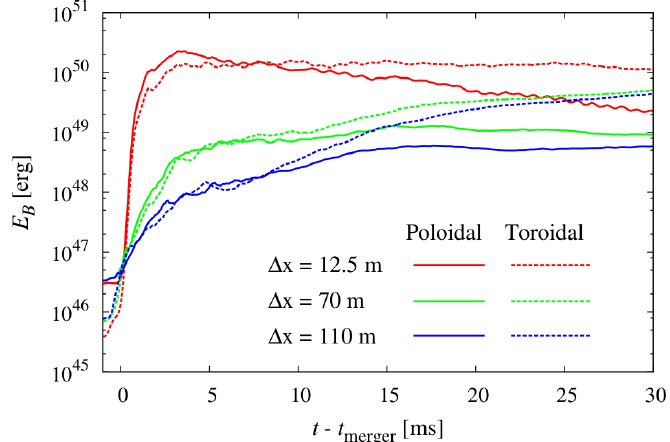
Figure 2. The evolution of the magnetic-field energy as a function of time from [125]. The growth of the magnetic field is evident in the first five milliseconds. However, the strong dependence on resolution indicates that the upper limit of amplification is unknown. Solid and dashed curves indicate the poloidal and toroidal magnetic field components, respectively. (Reprinted with permission from [125]. c (cid:13) (2018) by the American Physical